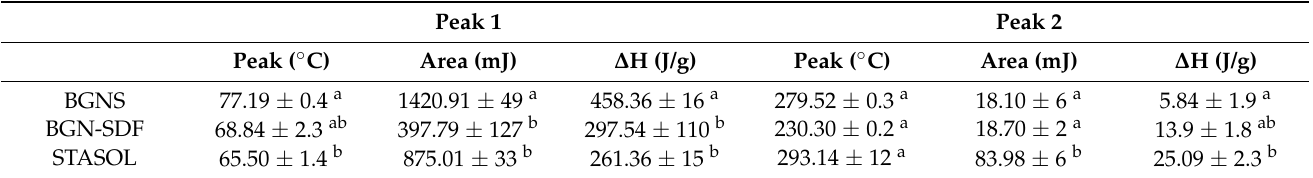
Table 3. Thermal properties of BGNS, BGN-SDF and STASOL using differential scanning calorimetry. Peak